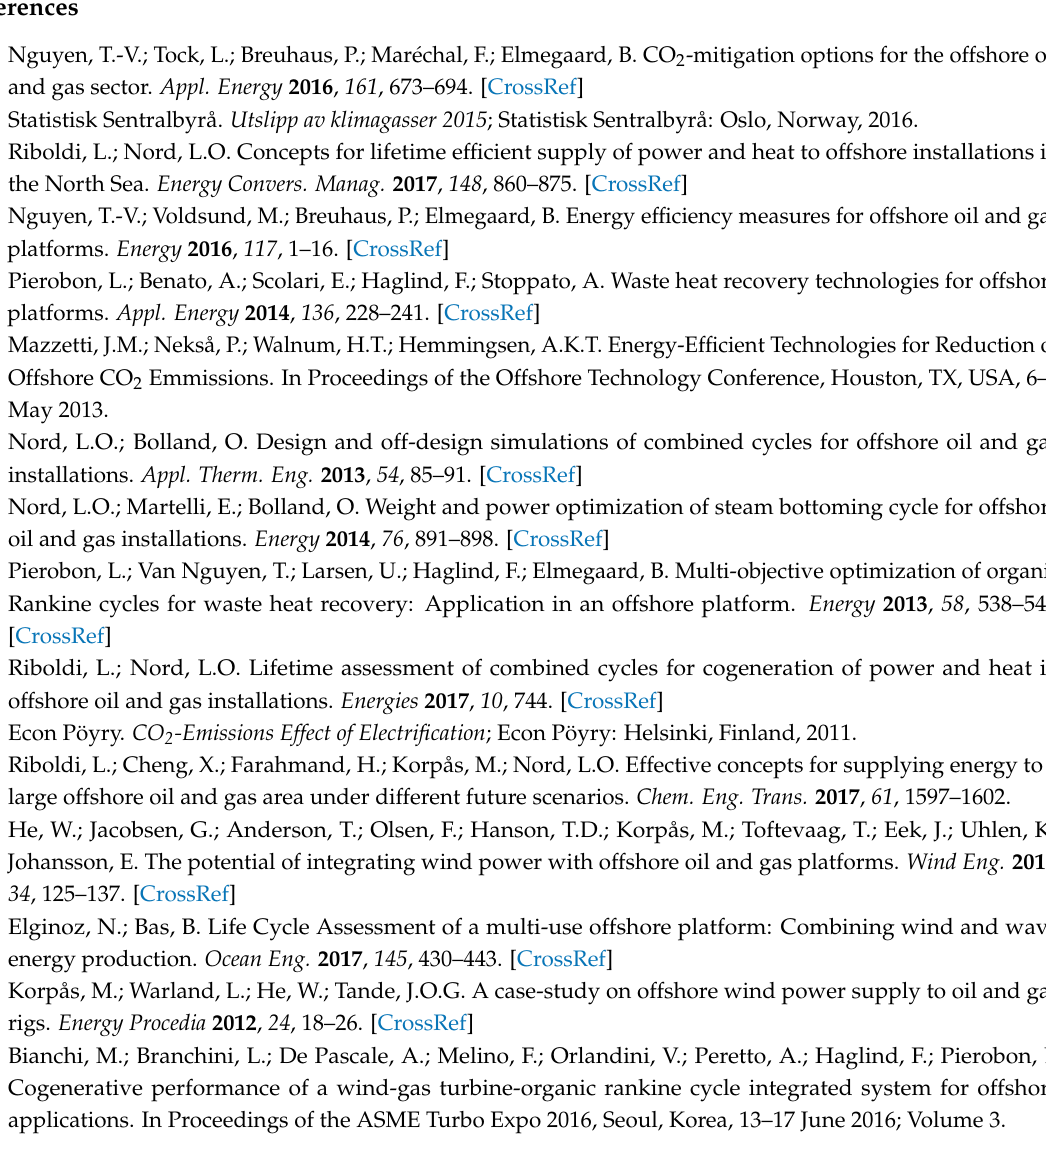
Figure A7. Parity plot of the steam flow rate for the off-design model validation.